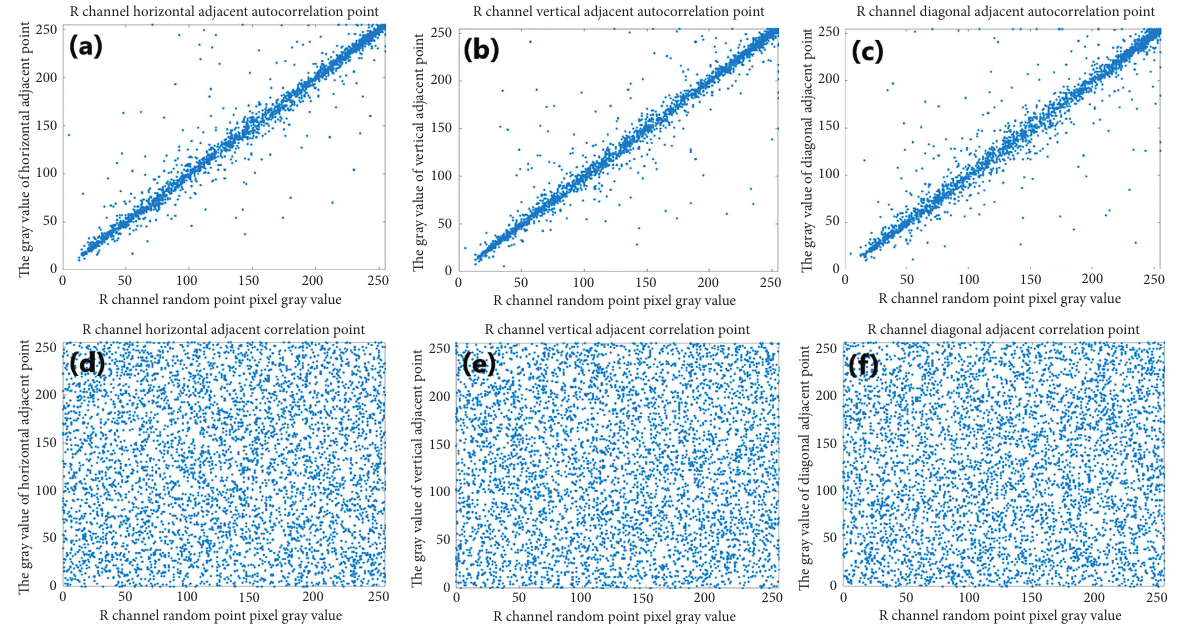
Figure 10: Correlation and autocorrelation of G channel adjacent pixels of the pepper image and its ciphered image: (a) horizontal direction of the pepper image; (b) vertical direction of the pepper image; (c) diagonal direction of the pepper image; (d) horizontal direction of the pepper ciphered image; (e) vertical direction of the pepper ciphered image; (f) diagonal direction of the pepper ciphered image.